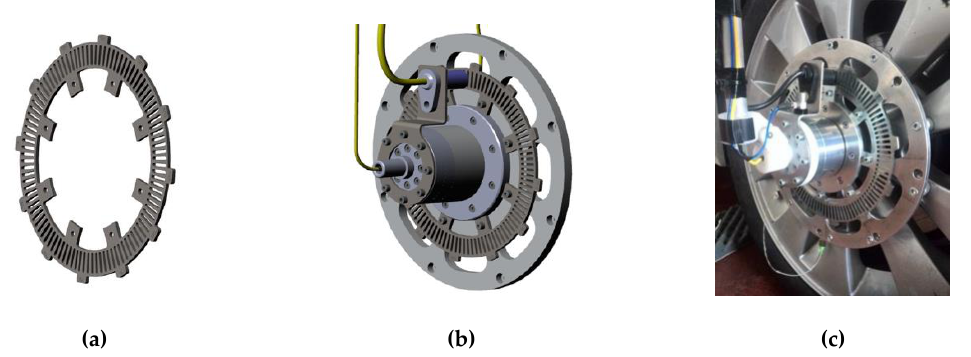
Figure 9. Phonic wheel design: in ( a ) the perspectives; in ( b ) the assembly; and ( c ) a picture of the phonic wheel installed on the support case.